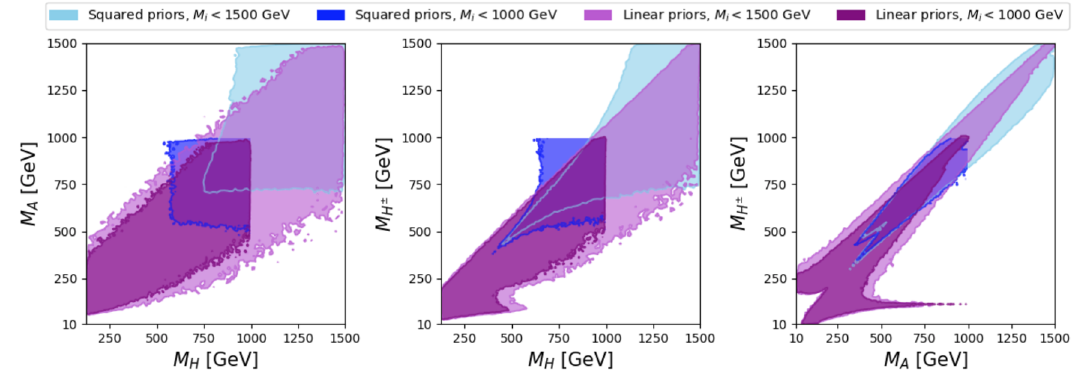
Figure 4. Allowed mass ranges from EWPOs at a 68% probability. Light and dark blue (purple) correspond to squared (linear) mass priors with M ∈ [10 , 1500] GeV and M H ∈ [125 , 1500] GeV H ± ,A (lighter regions) and with M ∈ [10 , 1000] GeV and M H ∈ [125 , 1000] GeV (darker regions). H ± ,A The same tendency is observed if lower mass regions are chosen. If the fit is repeated with linear mass priors (purple regions), masses as low as 10 GeV are allowed for the charged and CP-odd neutral scalars, at a 68% probability. In this case, the dependence on the input mass ranges is also weaker. The allowed regions for linear mass priors up to 1000 GeV (1500 GeV) are indicated in dark (light) purple